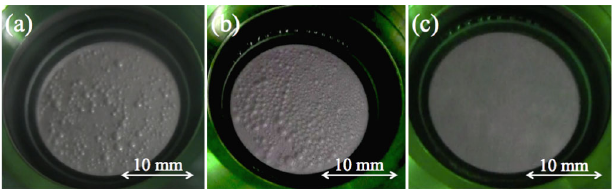
FIG. 6. Top iris viewport during VEP. (a) Bubbles in the case of the rod cathode, (b) bubbles before passing a blade of NC-1, and (c) a huge amount of bubbles, which removed sticking bubbles, while passing a blade of